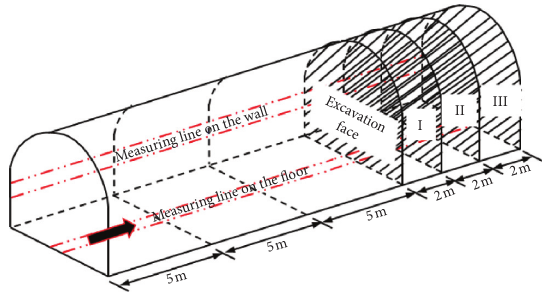
Figure 13: Layout of the measuring